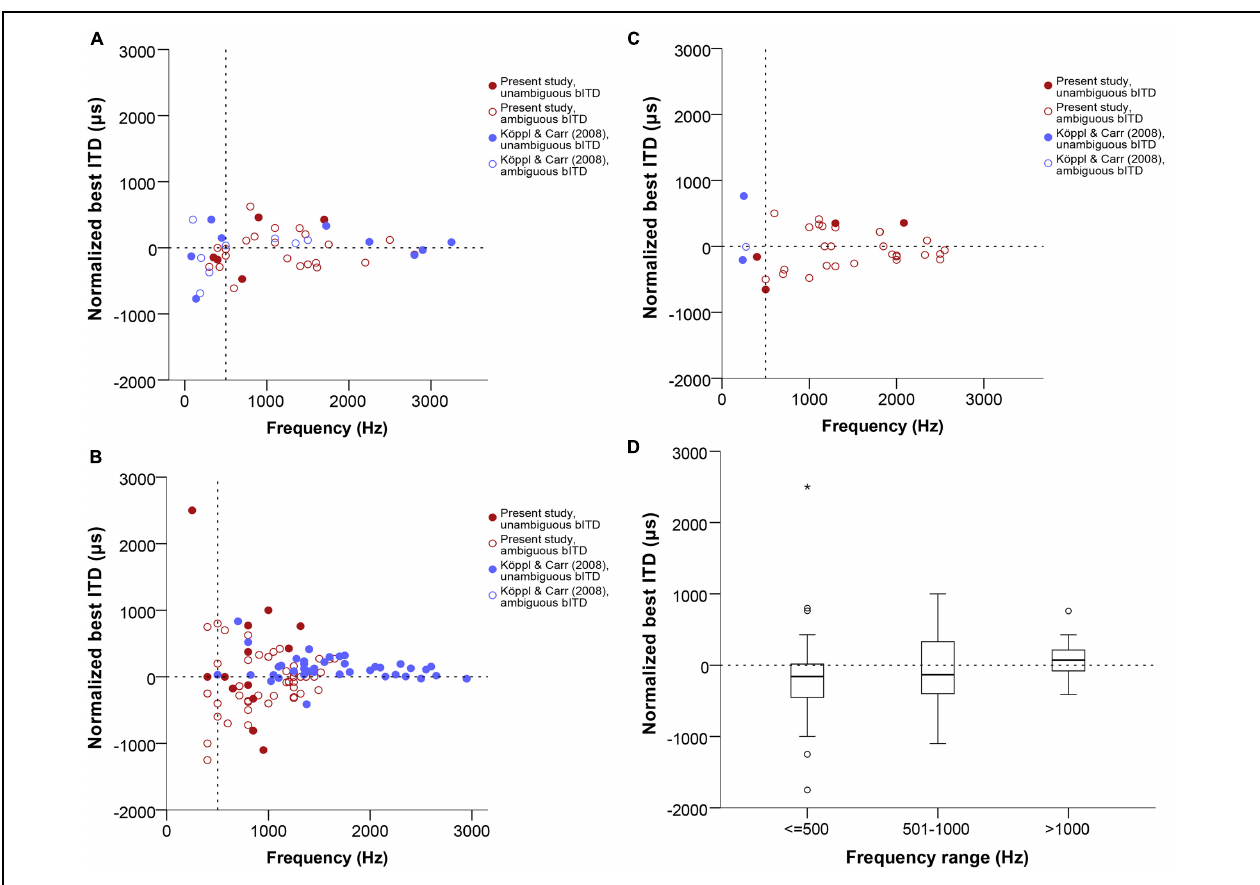
FIGURE 4 | Normalized best ITD in µ s as a function of stimulus frequency (Hz) near or at CF, separate for single units (A), multi units (B), and neurophonics (C). In order to easily visualize and compare data across all three panels the extreme outlier at − 4312 µ s is not shown. Red data points are data from this study, blue data points are data from Köppl and Carr (2008). Filled and open symbols represent ambiguous and unambiguous bITDs respectively. (D) Box plot of the best ITD distribution of all datasets